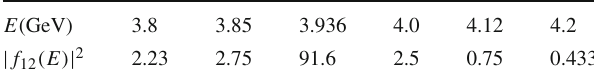
Table 3 The values of the | f 12 ( E ) | 2 near the D s ¯ D s threshold